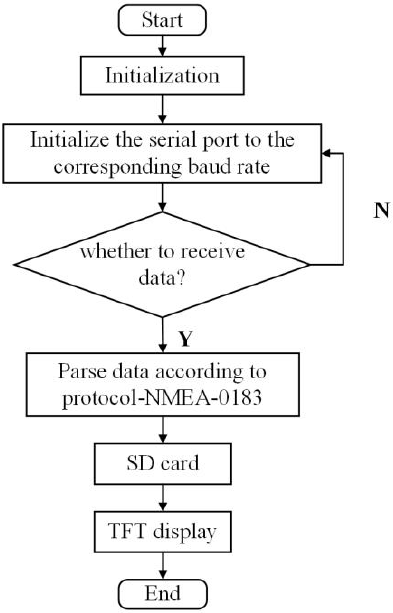
Table 1. Parameters of ATK-1218-BD/GPS